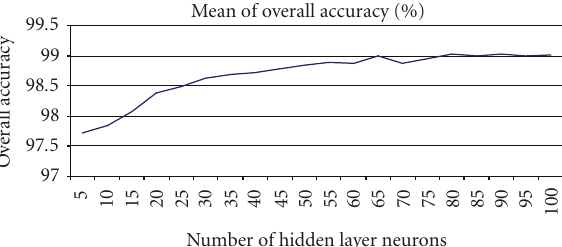
Figure 5: E ff ect of hidden layer neuron number on average overall accuracy (%) with multilayer perceptron.